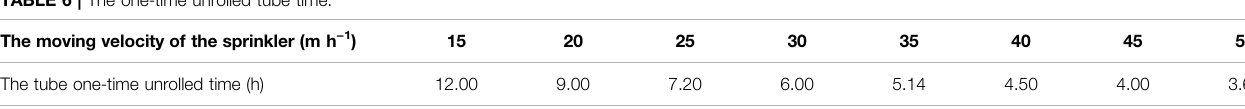
TABLE 6 | The one-time unrolled tube time.